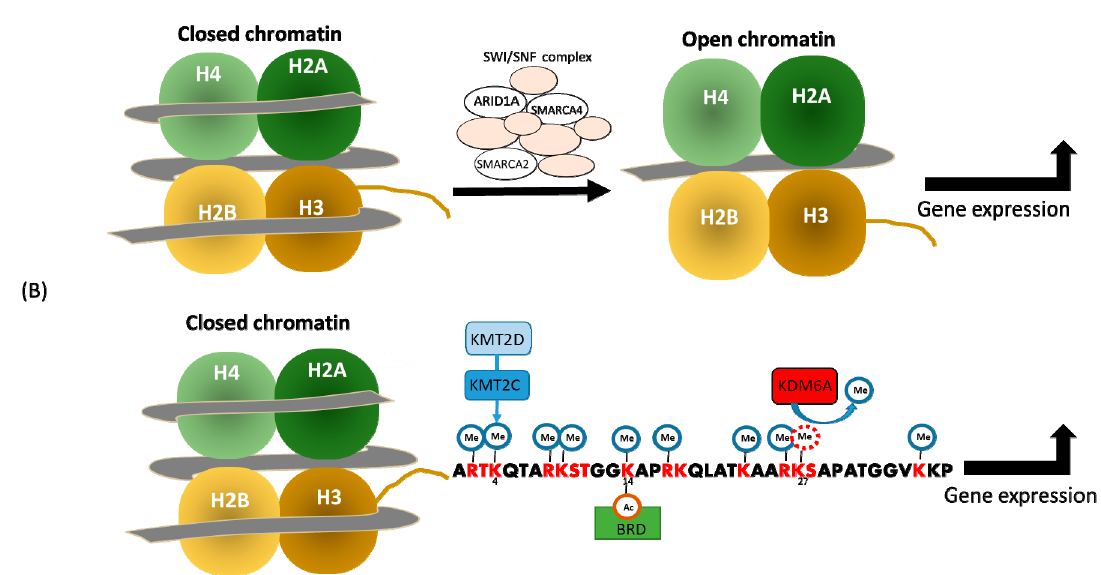
Figure 1. Epigenetic regulation of the SWI/SNF complex, lysine methyltransferase, and